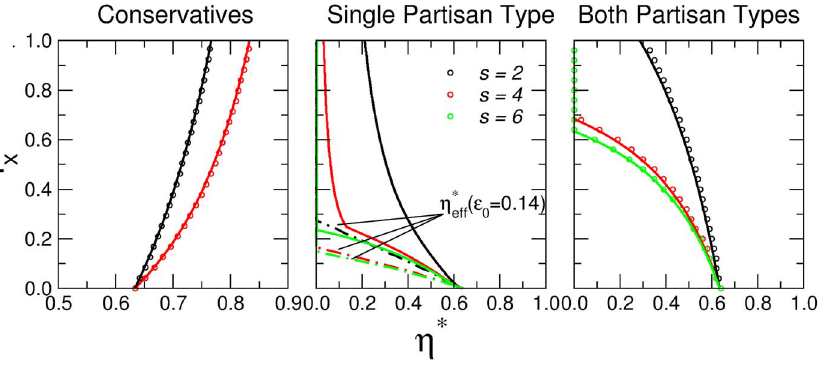
Figure 2. Transition line for the mean-field solution for a mixed population of agents with. g (cid:3) ( f X , s ) k ~ 6 We plot the noise amplitude g (cid:3) at which the positive efficiency solution ceases to be stable (see Fig. 1) for a fraction f X of non-naive agents and for different bias strengths s ~ 2,4,6 (see text for the conservative case and s ~ 6 ). Solid lines show the numerical solution for the steady state condition and dots show the theoretical values from Eqs. (12) (conservatives) and (14) (both types of partisans). For the symmetric cases, those with conservatives and both types of partisans , the line separates the efficient regime for low values of noise amplitude from the non-efficient regime. In the case in which there are only negative partisans, the line separates the efficient regime from the partisan regime in which the system is drawn into a consensus on the opinion held by the initial minority opinion. Note how in the symmetric case g (cid:3) is independent of 0 , the efficiency of the system at time zero. However, in the non- symmetric case of only negative partisans, the transition line depends on the initial efficiency E 0 . As a guide we show transition lines for E 0 ~ 1 (solid lines) and E 0 ~ 0 : 14 (dotted lines).